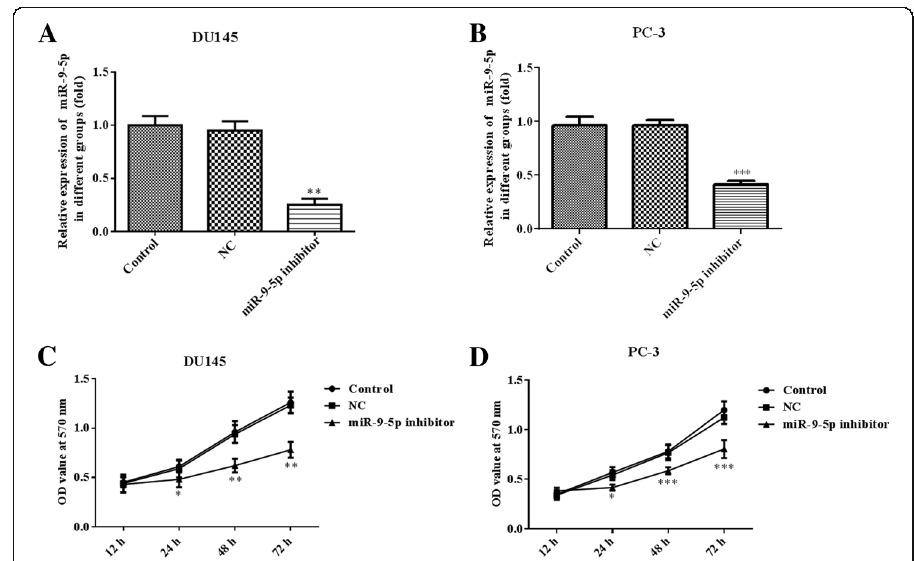
Fig. 2 The levels of miR-9-5p expression and cell proliferation in DU145 and PC-3 cells transfected with an miR-9-5p inhibitor. The mRNA expression of miR-9-5p in DU145 cells ( a ) and PC-3 cells ( b ) transfected with miR-9-5p inhibitor or NC were determined using quantitative RT-PCR. DU145 cells ( c ) and PC-3 cells ( d ) were transfected with miR-9-5p inhibitor for 12, 24, 48 and 72 h, and cell proliferation was measured by CCK8 assay. * p < 0.05; ** p < 0.01; *** p < 0.001 vs. NC group. All